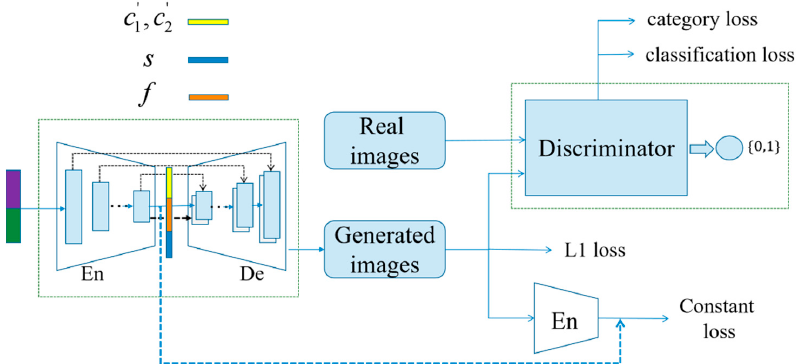
Figure 7. The architecture of font generation. The features of the characters in the source font strive to have low-level information via the encoder. Then the abstracted information combines with style information s, classification information f , and guided information c(c 1’ ,c 2’ ), the output of which can be regarded as the characteristics extracted in the combined target domains that depend on the guided information c(c 1 ’ ,c 2 ’ ). The skip connections between encoder and decoder aim to share the low-level information. Finally, the generated images are decoded.